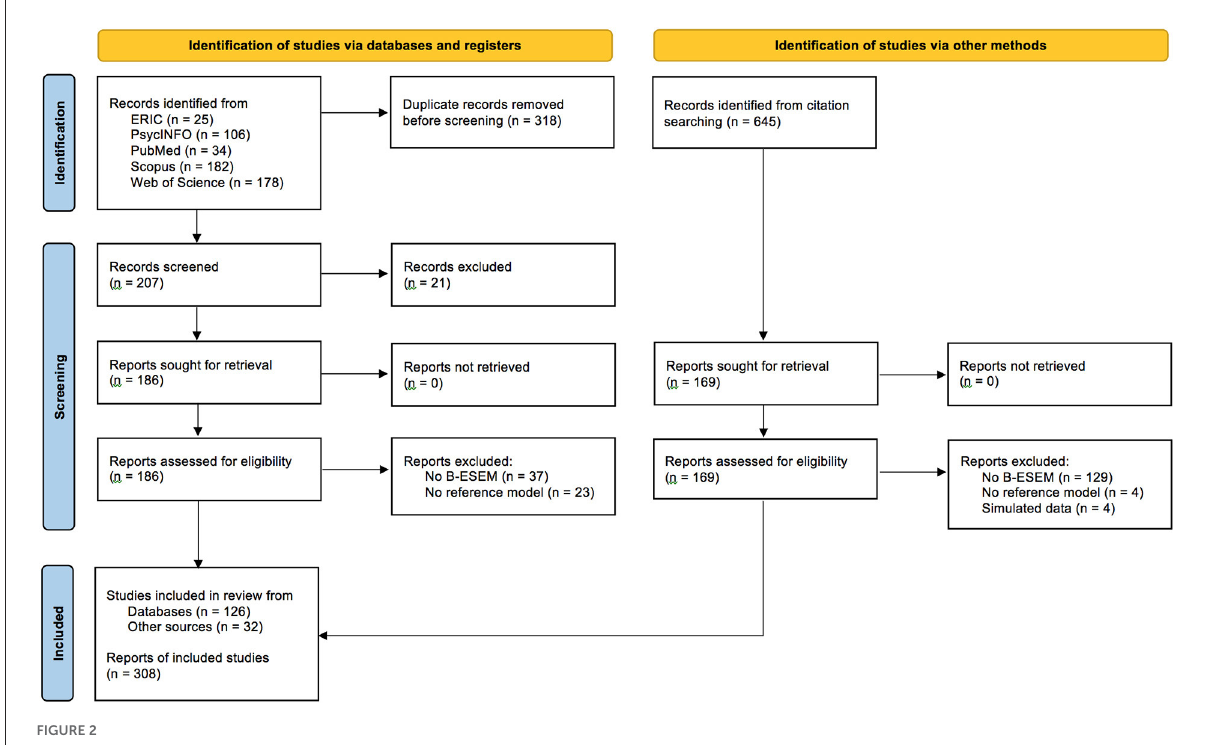
FIGURE2 PRISMA study selection flow